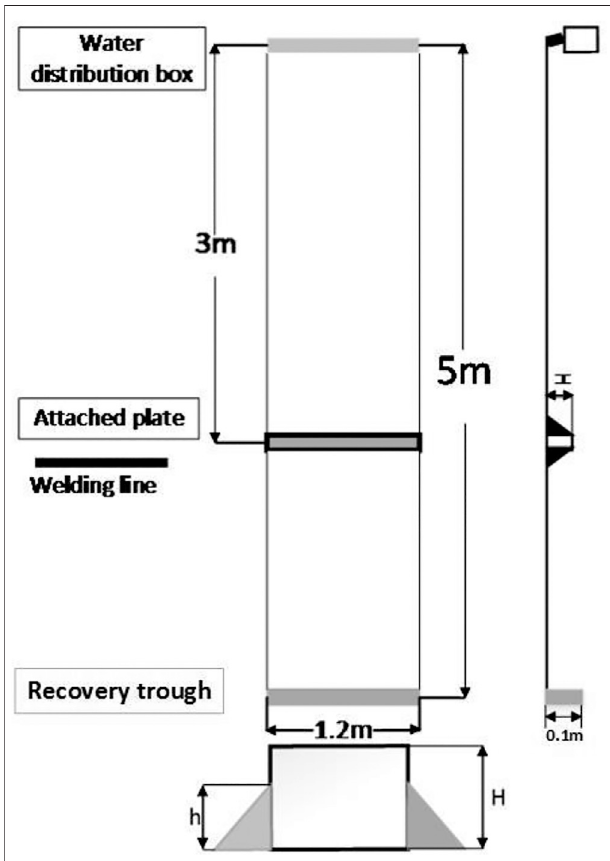
FIGURE 3 | Schematic of test plate and attached